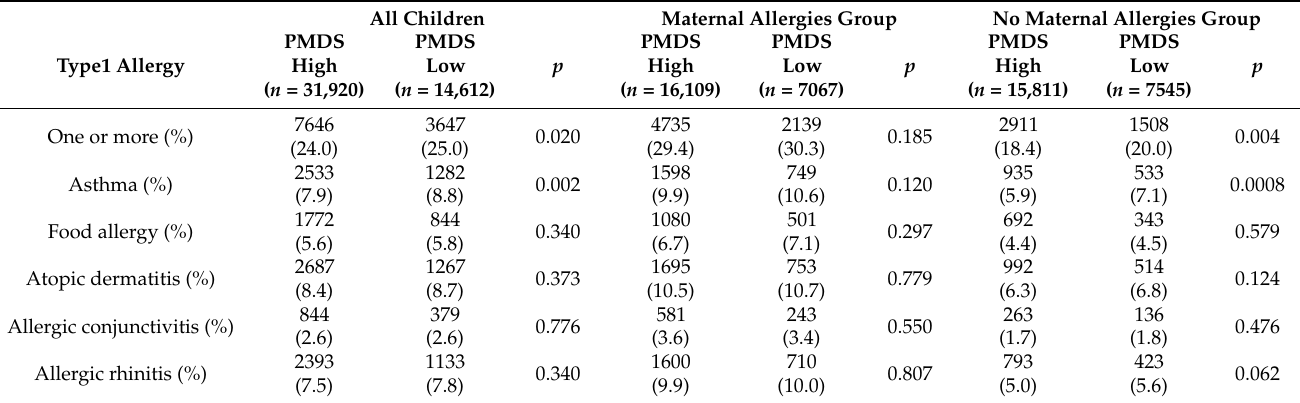
Table 4. Comparison of allergic outcomes between the two PMDS groups. All Children Maternal Allergies Group No Maternal Allergies